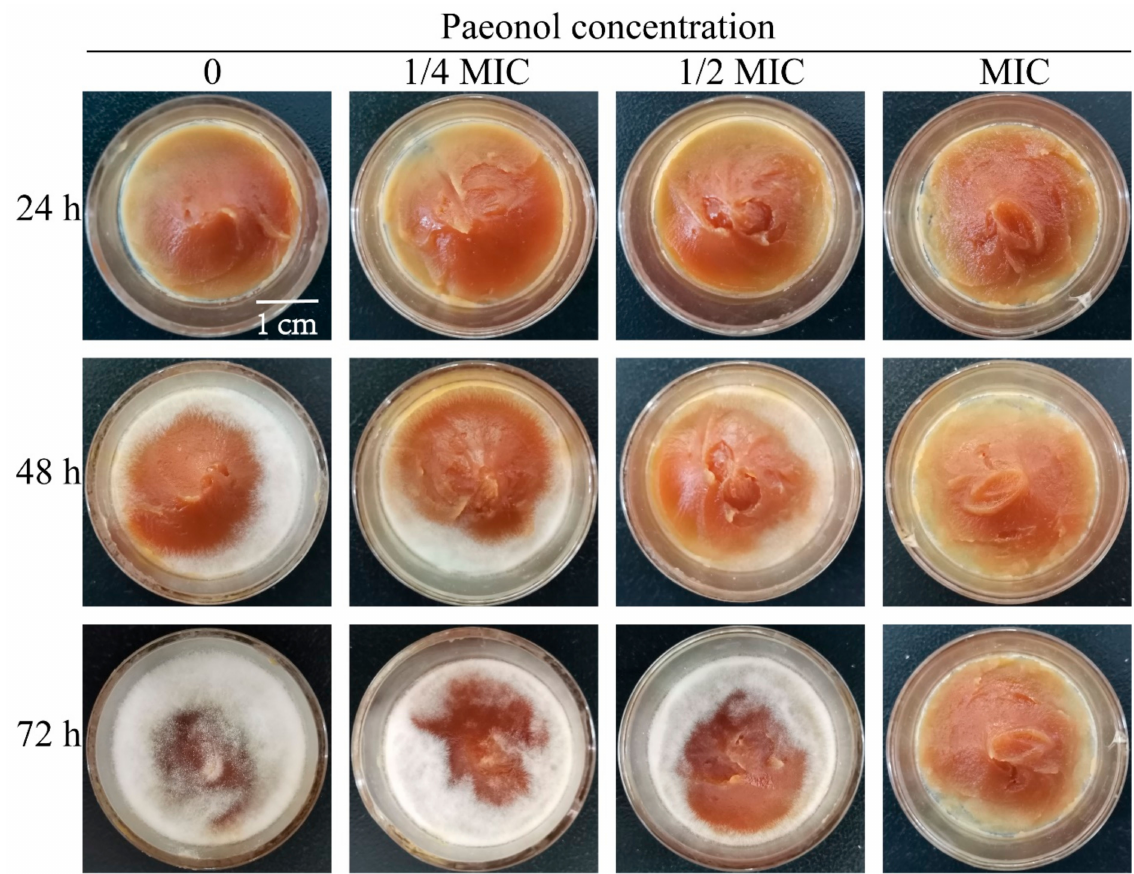
Figure 7. Antifungal effect of paeonol in vitro on peanut